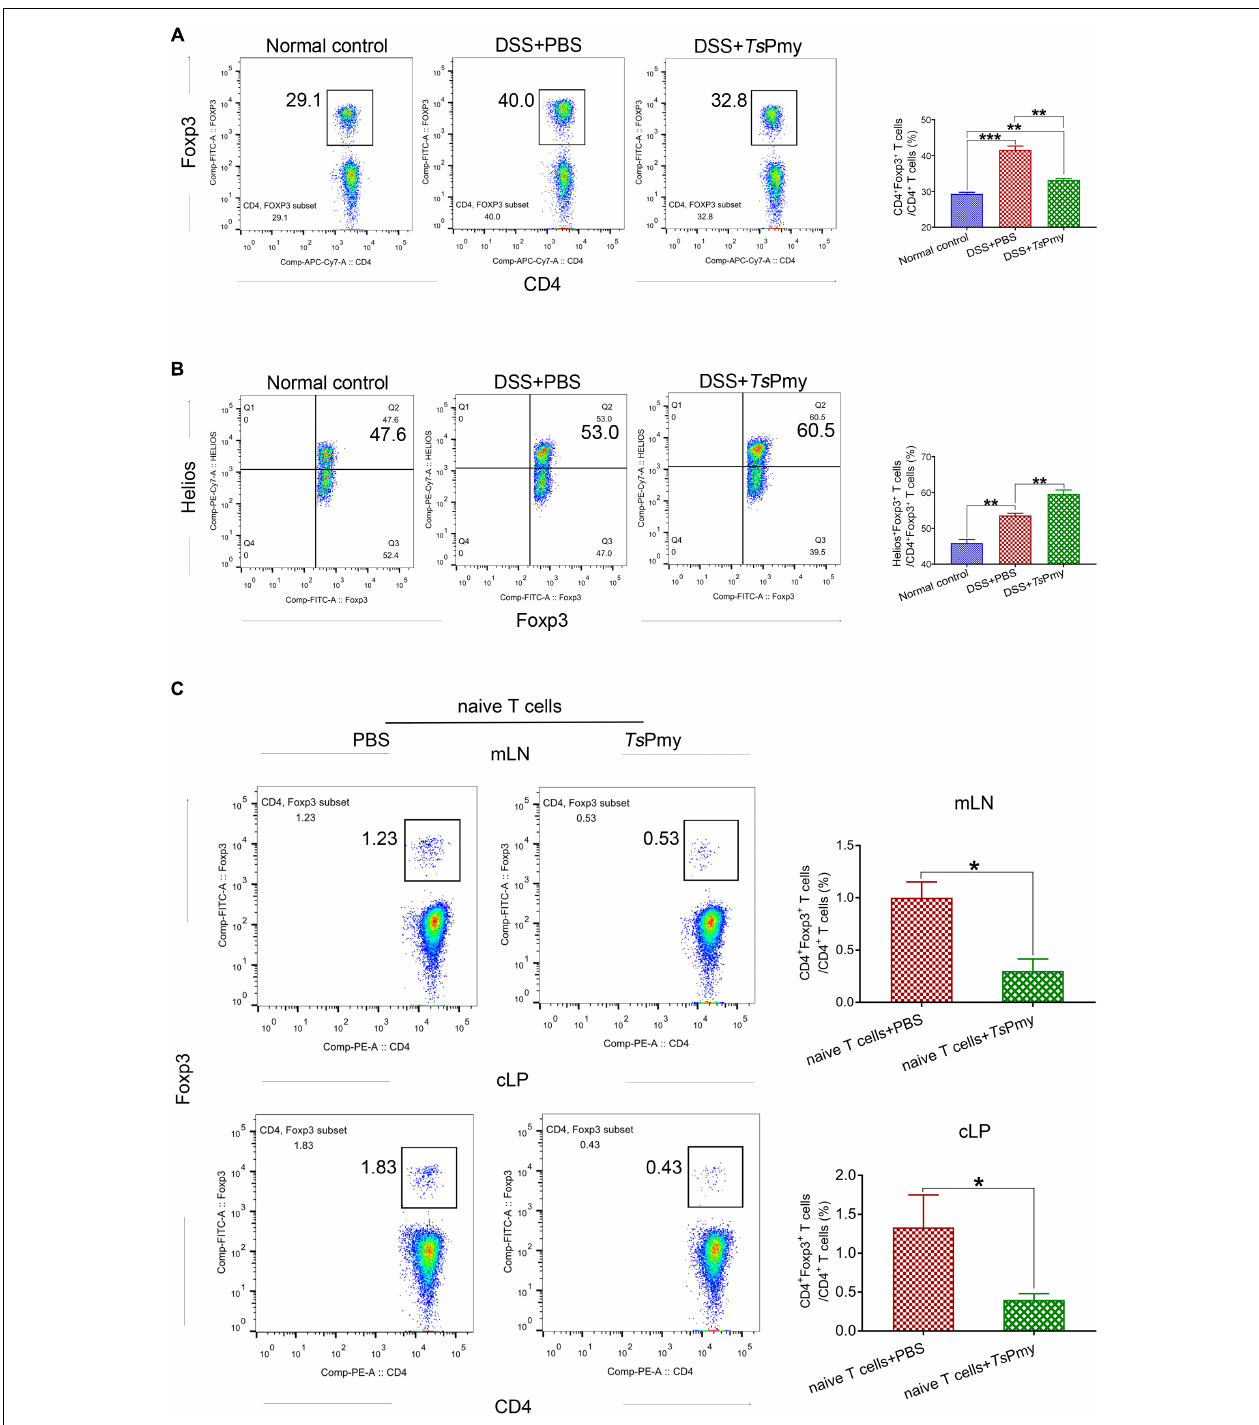
FIGURE 5 | Treatment with r Ts Pmy specifically increases Helios + tTreg expansion but could not induce pTreg differentiation in mLN and cLP in colitis. (A) The percentage of CD4 + Foxp3 + Tregs in cLP from r Ts Pmy- or PBS-treated mice. The gating strategy is shown in Supplementary Figure 2 . Statistical analysis is shown on the right ( n = 5). (B) The frequency of Helios + cells in Foxp3 + T cells of cLP from r Ts Pmy- or PBS-treated mice. The gate strategy is shown in Supplementary Figure 3 . Statistical analysis is shown on the right ( n = 5). (C) The percentage of Foxp3 + (eGFP) cells in CD3 + CD4 + T cells of mLN (top) and cLP (bottom) at 5 weeks after CD4 + Foxp3 − CD45RB hi naïve T-cell adoptive transfer into Rag1 KO mice. The gate strategy is shown in Supplementary Figure 4 . Frequencies are shown on the right ( n = 3). Naïve T cells were from Foxp3 eGFP mice. Results are shown as mean ± SEM. * p < 0.05, ** p < 0.01, *** p < 0.001. mLN, mesenteric lymph nodes. cLP, colonic lamina propria. See also in Supplementary Figure 5 .